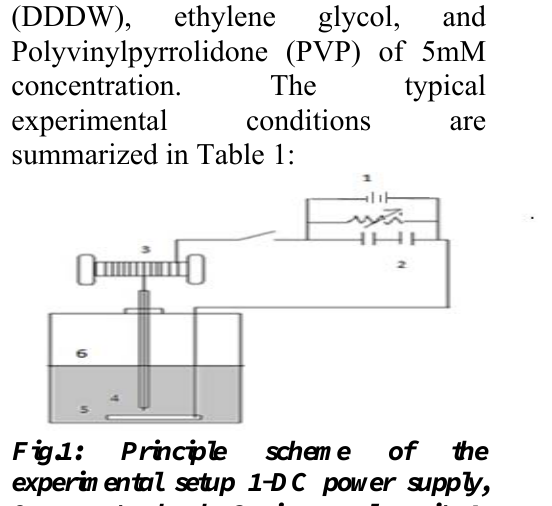
Fig.1: Principle scheme of the experimental setup 1-DC power supply, 2-capacetor bank, 3-wire supply unit, 4- exploding wire guide, 5-plate, 6-explosion chamber containing